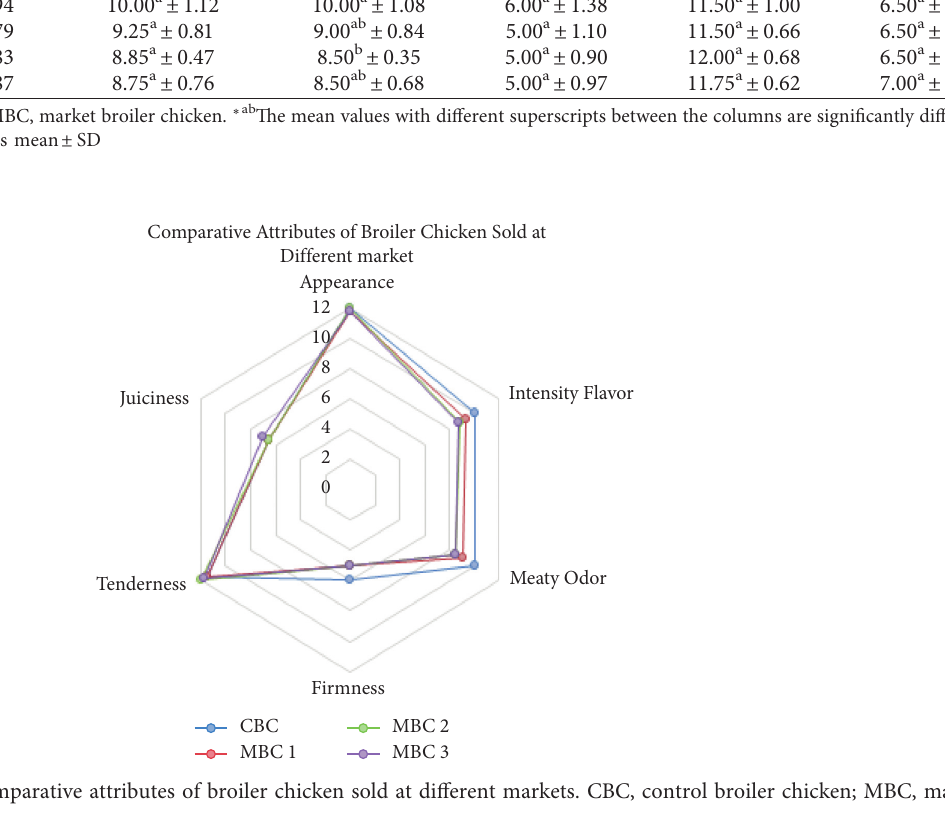
Table 14: Comparative attributes between control broiler chicken (CBC) and market broiler chicken (MBC) sold at the market. Samples